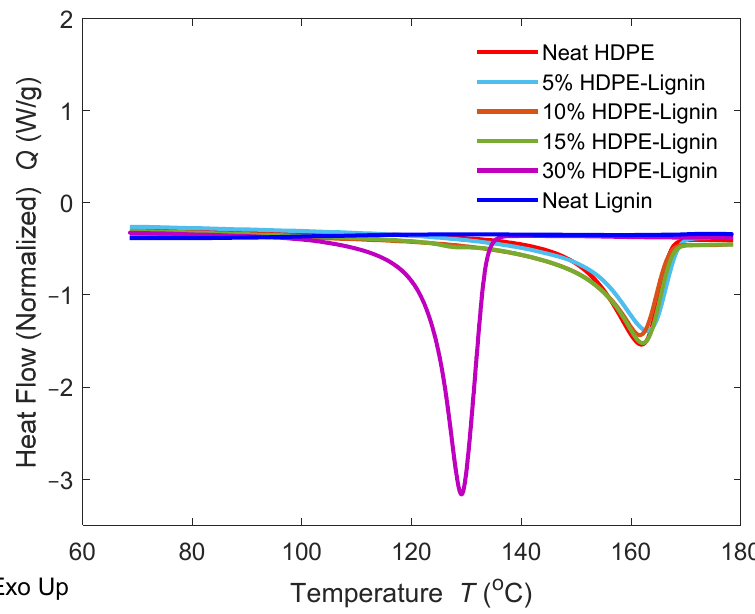
Figure 4. The DSC traces of HDPE/lignin blends recorded during the first heating scan. Table 3. DSC test results. Blend Composi- tion